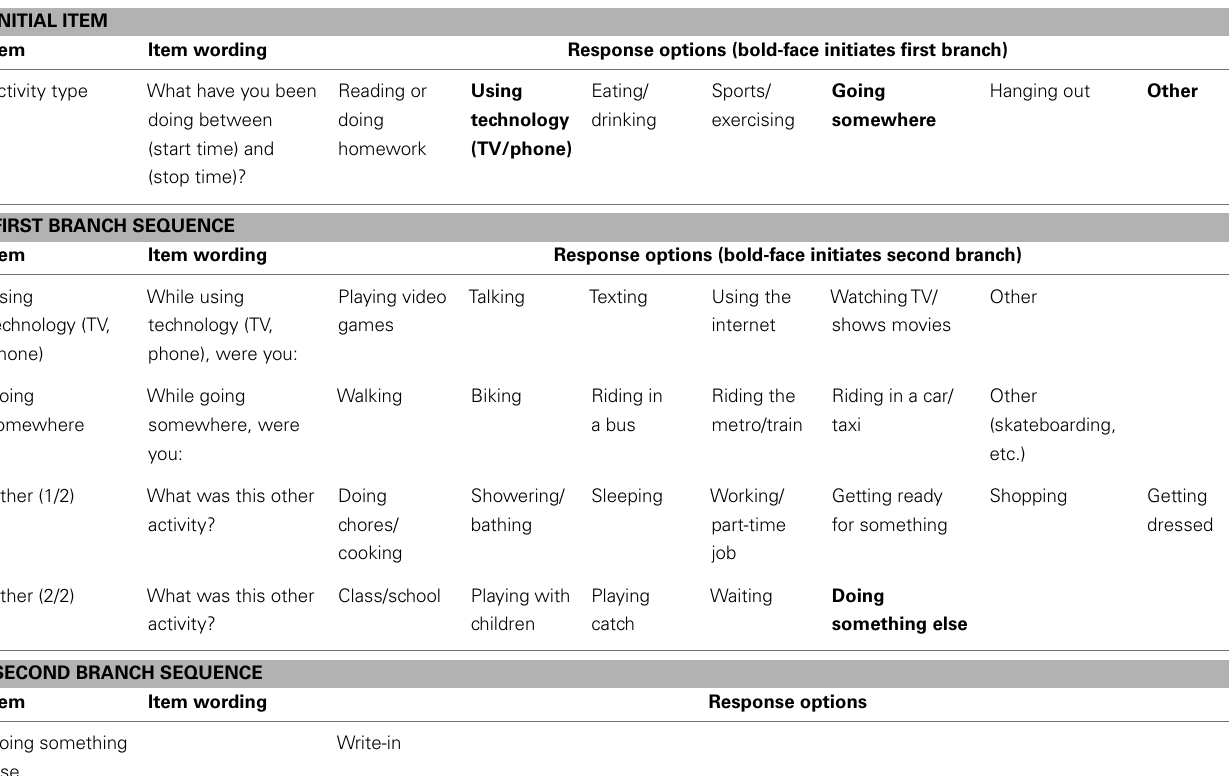
Table 2 | Branching sequence for the activity type ecological momentary assessment (EMA) item